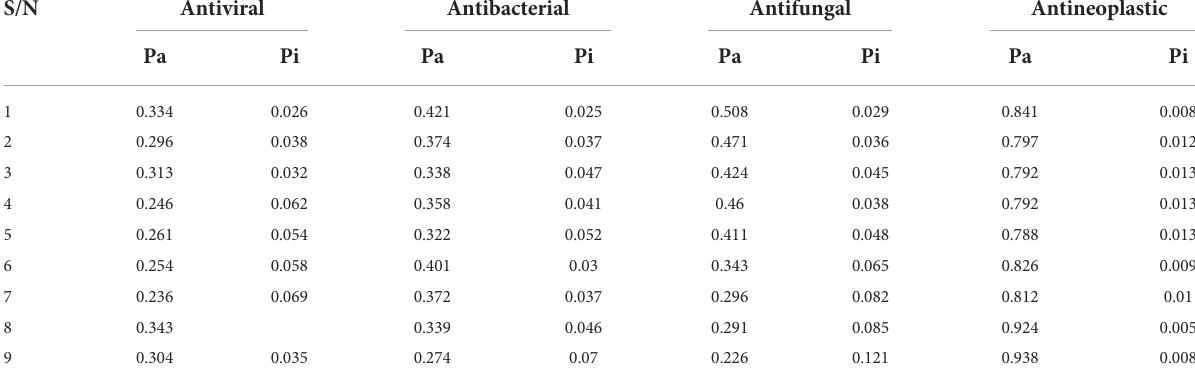
TABLE 1 Biological PASS prediction spectrum